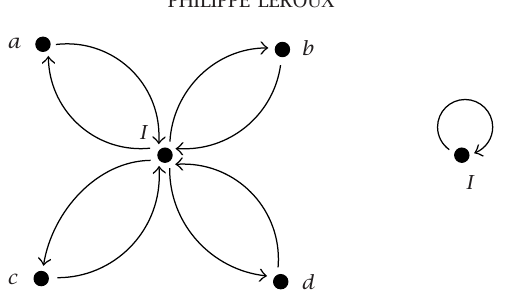
Figure 3.2 . Example of geometric support associated with an alge- bra k { a,b,c,d }⊕ kI